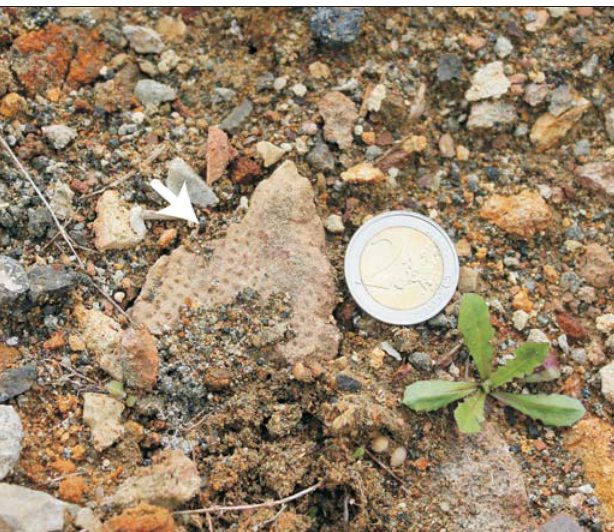
Fig. 12. In situ Eocene specimen of Laocoetis patula from Lovara Quarry, Italy; showing its characteristic morphology with canal openings in quad- rate arrangement, indicated by the white arrow. Coin for scale is 22 mm in